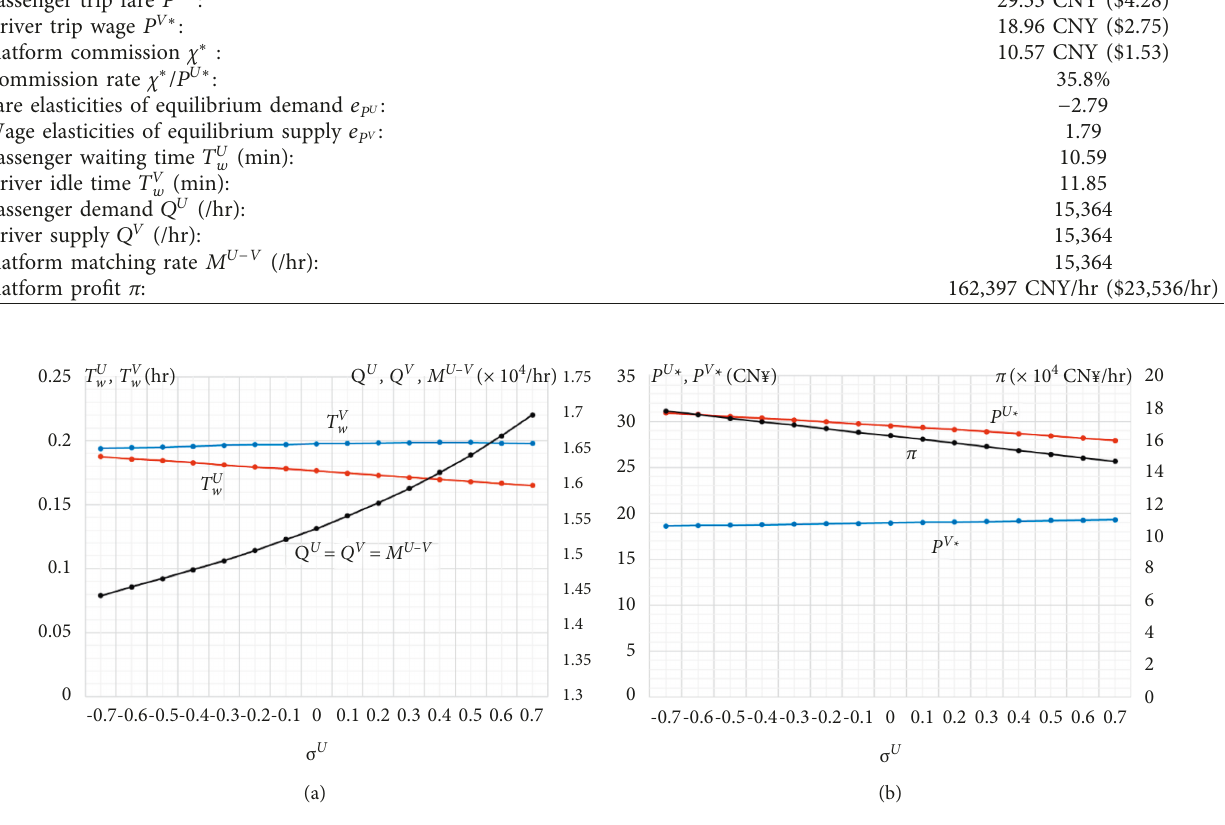
T V Q U , Q V , and M U − V . (b) Changes in P U ∗ , w , w ,